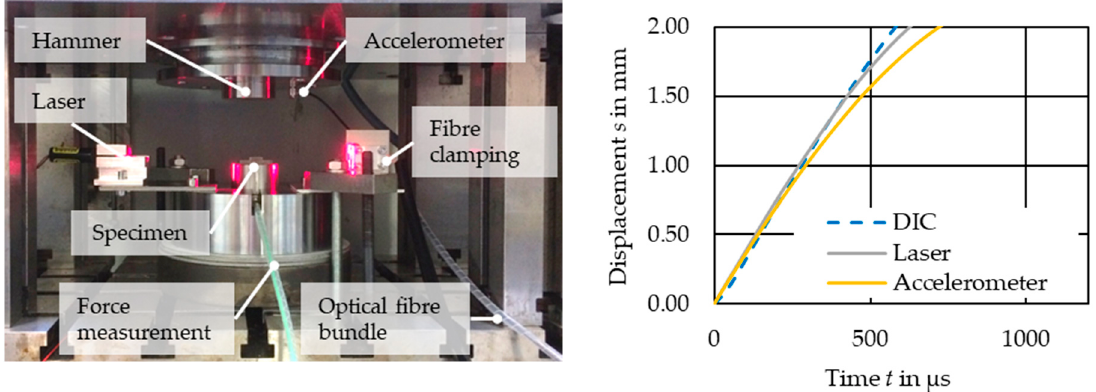
Figure 5. Measurement of the hammer displacement.